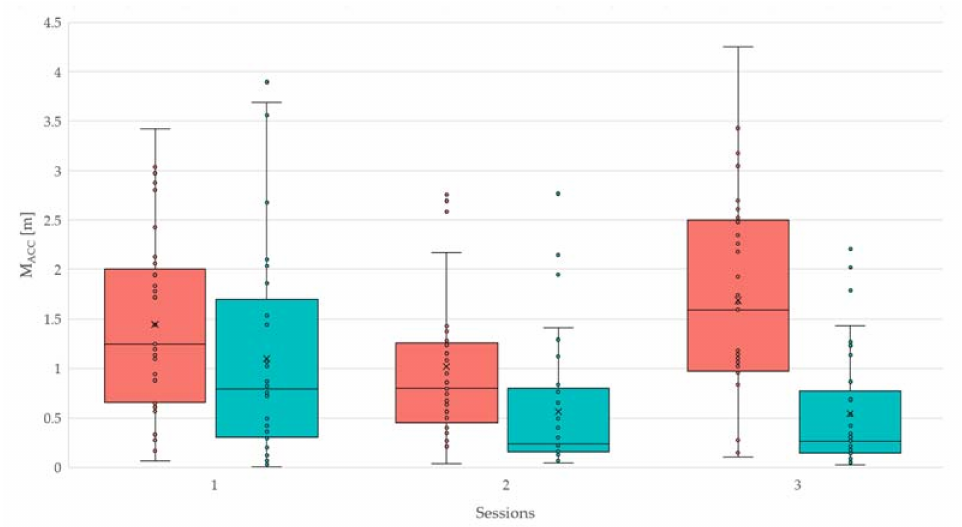
Figure 5. Accuracy for the LT700H (red color) and Stonex S900A (green color) divided by the three independent observation